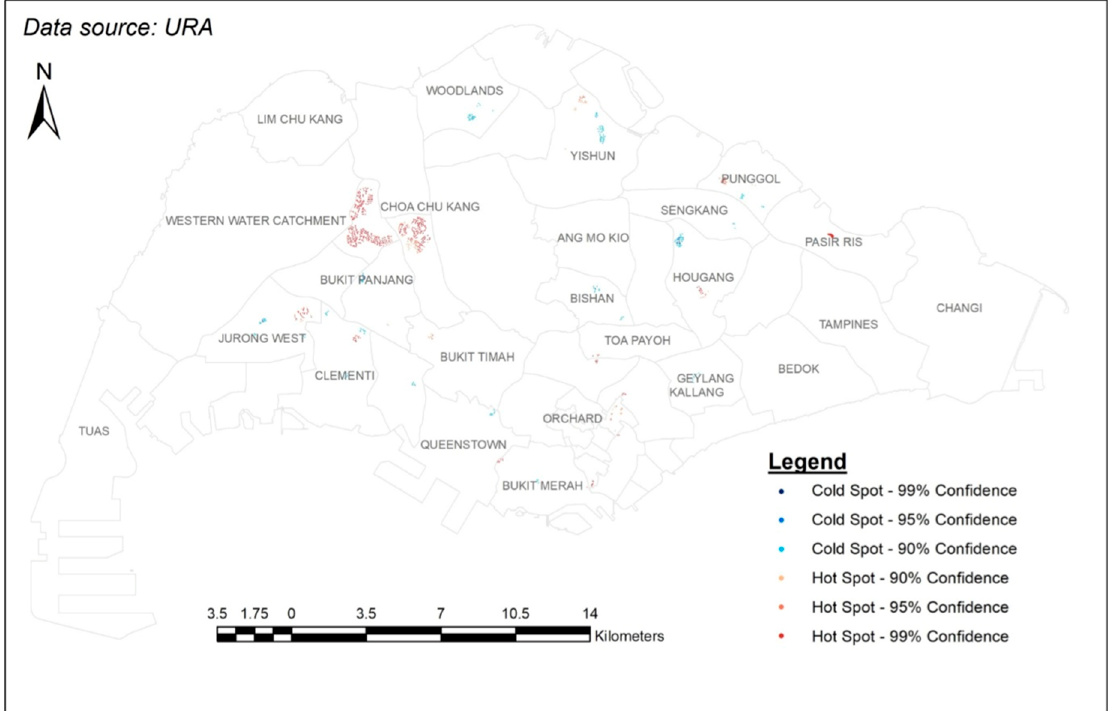
Figure 6. Results of hot spot analysis against the planning boundaries of Singapore.